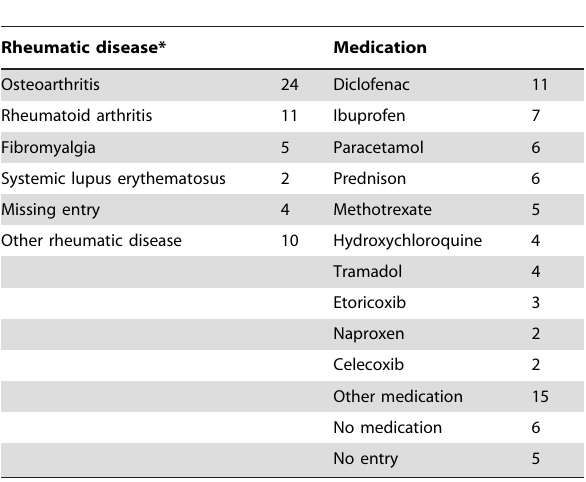
Table 1. Characteristics of the